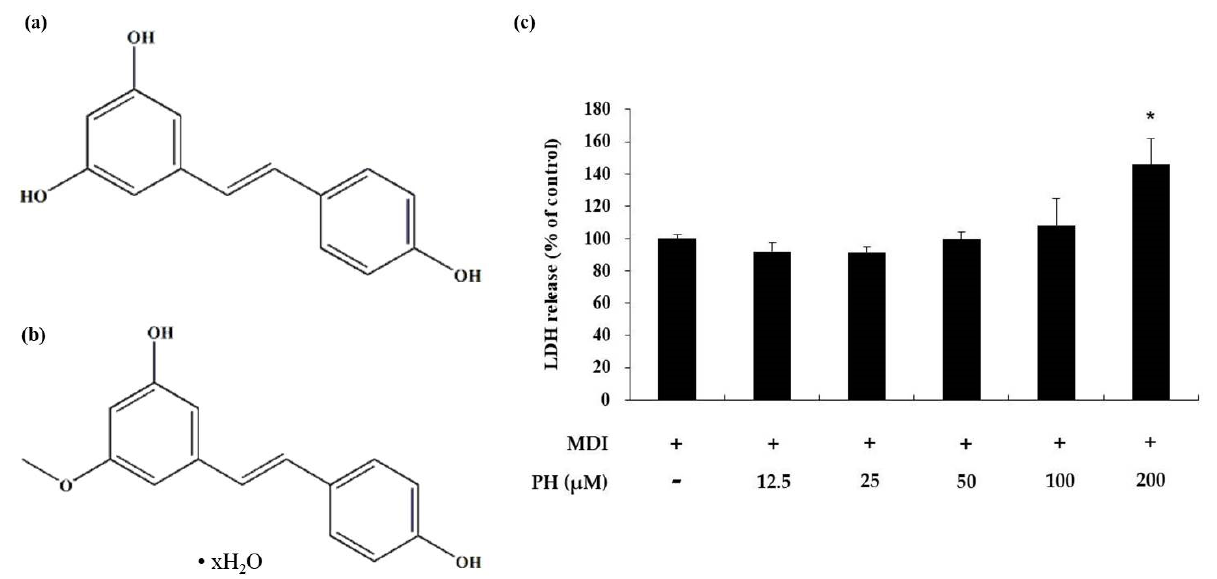
Figure 1. Effects of PH on cytotoxicity in 3T3-L1 adipocytes. The chemical structure of ( a ) resveratrol and ( b ) pinostilbene hydrate. Adipocyte differentiation was induced in post-confluent cells using IBMX/DEX/insulin (MDI) differentiation medium, and the cells were treated with the indicated concentrations of PH for 48 h. ( c ) Cytotoxicity was measured using the LDH assay. LDH release is expressed as percentages relative to the control group (MDI treated only). All values are presented as the mean ± standard deviation. ( n = 3 per group). * indicates significantly different versus MDI alone ( p < 0.05).